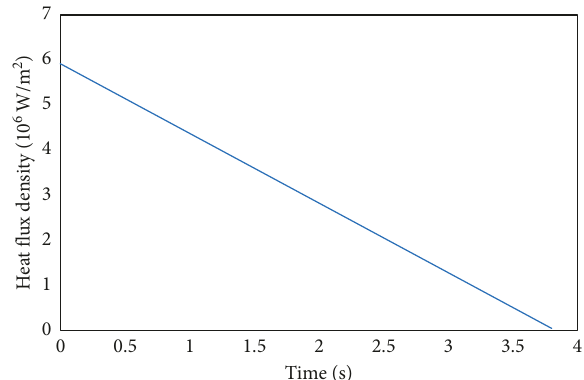
Figure 9: Input heat flux density for emergency braking conditions.